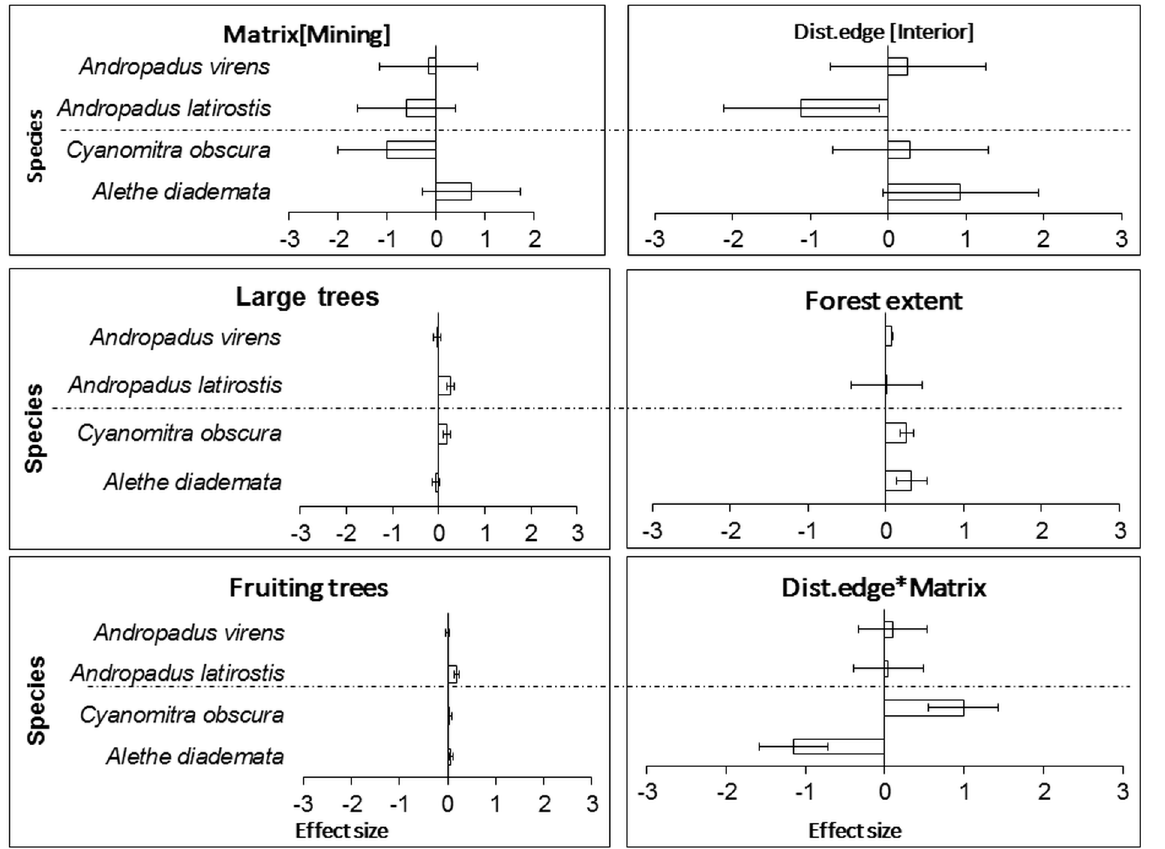
Fig 6. Model-averaged coefficients (error bar = 95% CI) of explanatory variables ’ influence on subcutaneous fat score of all case study species. Generalist above the horizontal dashed line and specialists below in each panel.